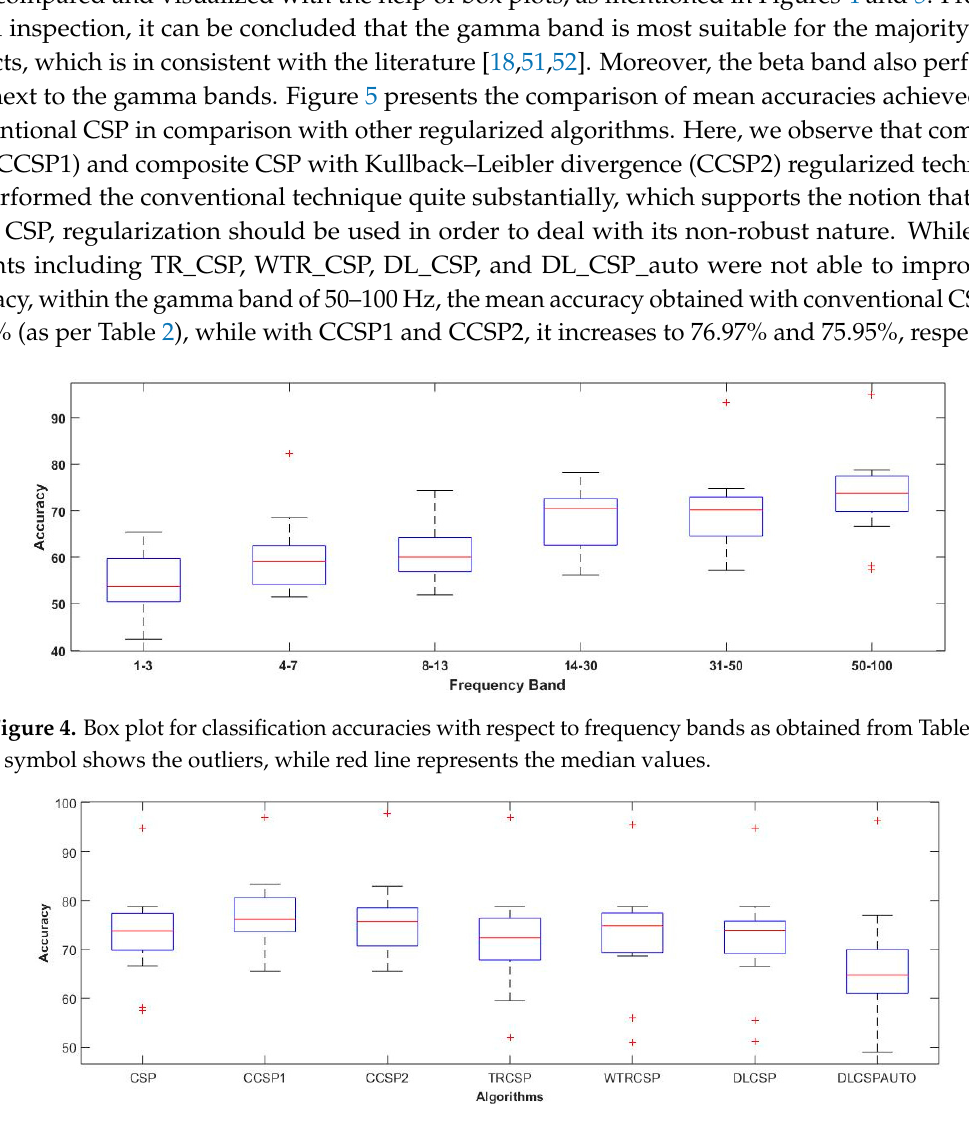
Figure 5. Box plot for classification accuracies with respect to different feature extraction techniques as obtained from Table 3. + symbol shows the outliers, while red line represents the median values. CCSP—composite CSP; TR_CSP—CSP with Tikhonov regularization; WTR_CSP—CSP with weighted Tikhonov regularization; DL_CSP—CSP with diagonal loading using cross validation.